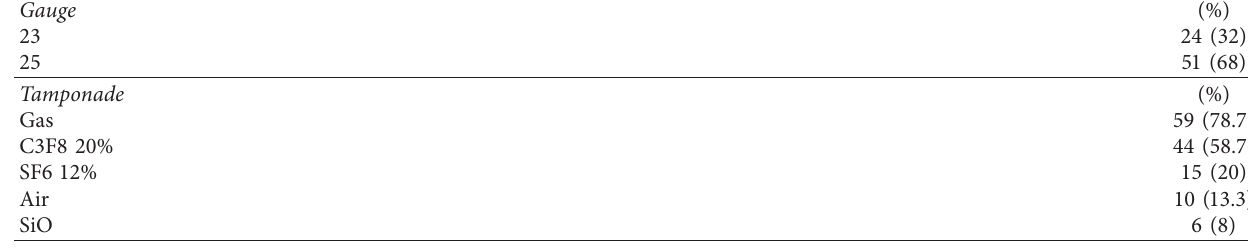
Table 3: Surgical procedures (75 patients).